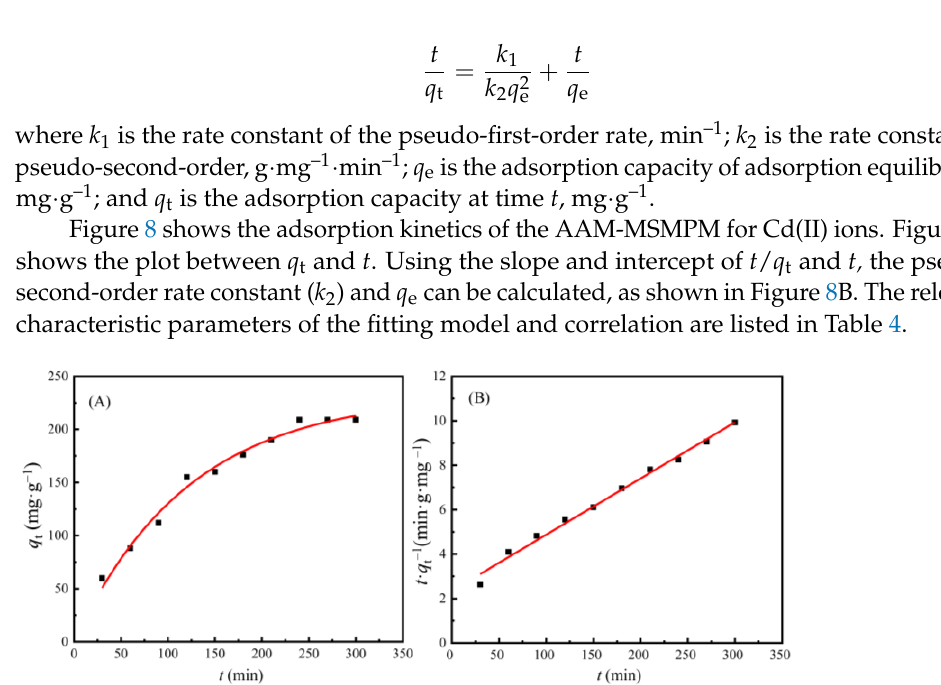
order ( A ) and pseudo-second-order ( B ).